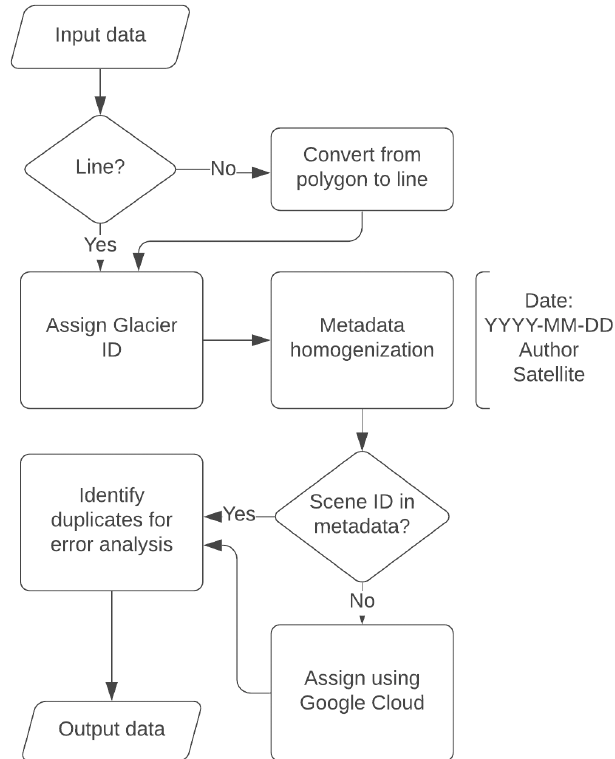
Figure 1. Flow chart showing processing pipeline for producing consistent terminus trace training